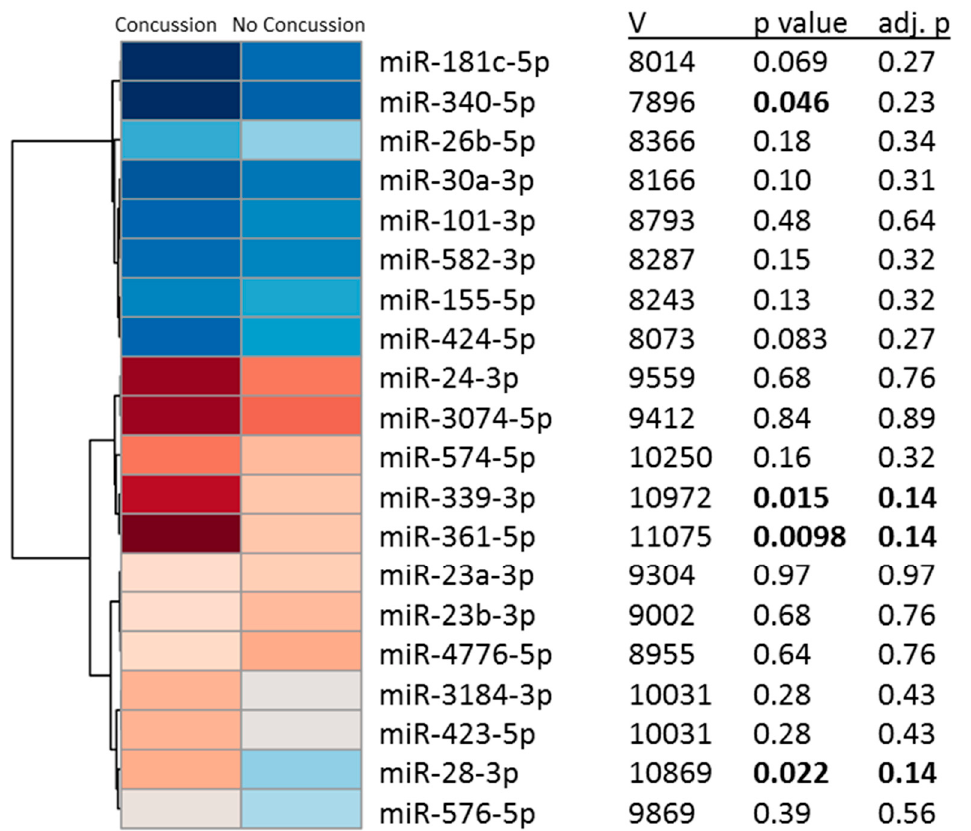
Table 3. Physiologic targets of candidate miRNAs.